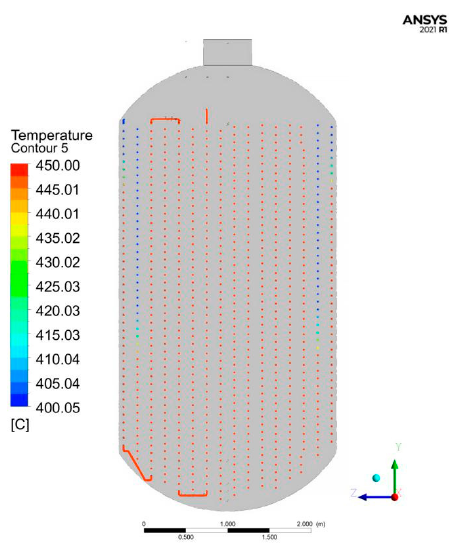
Figure 6. Y-Z plane temperature nephogram of